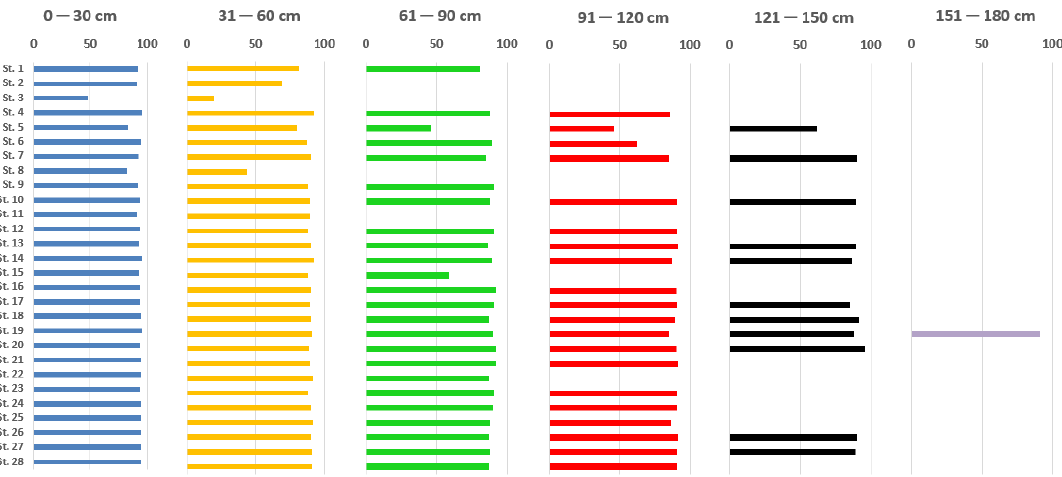
Figure 6. Mean hydration of the bottom sediment of Karczemne Lake (%).